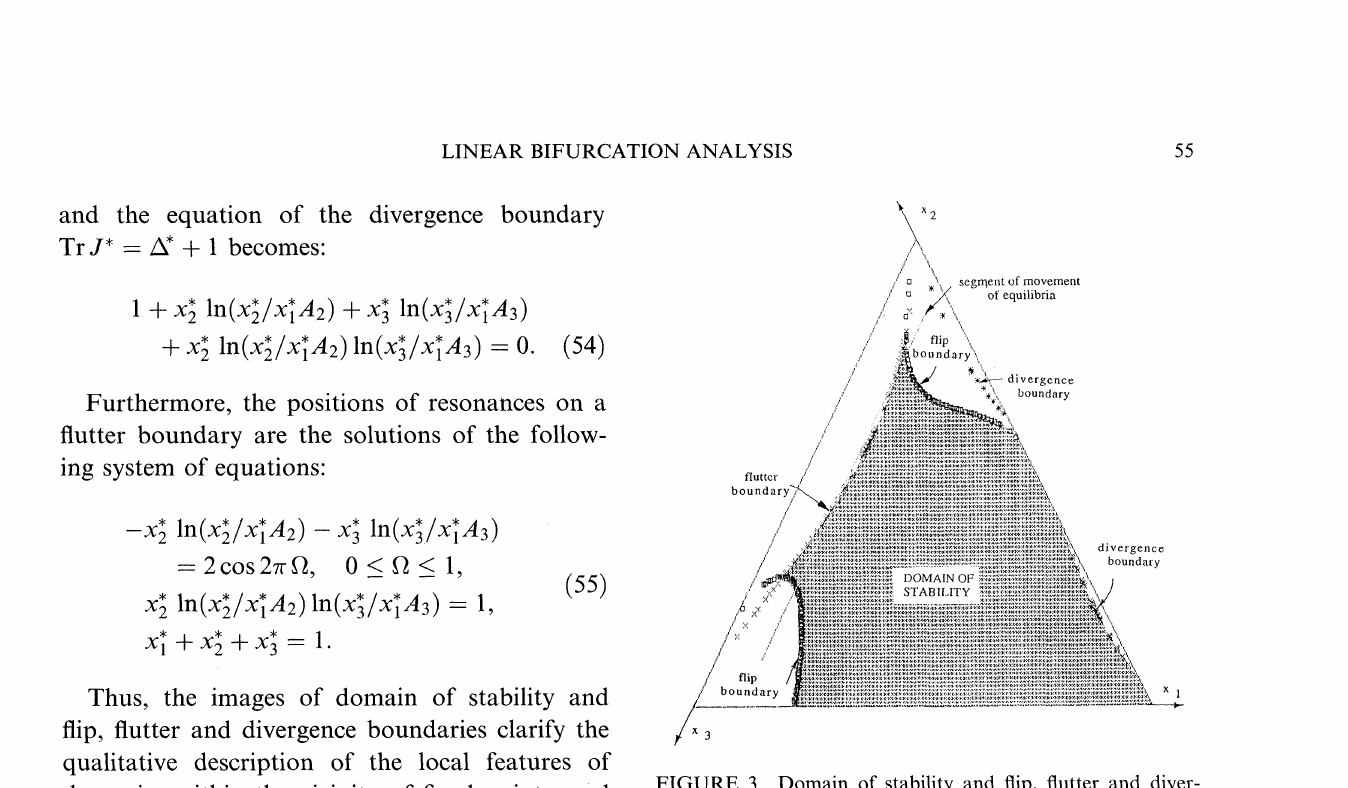
FIGURE 3 Domain of stability and flip, flutter and diver- gence boundaries of one population/three location relative dynamics.